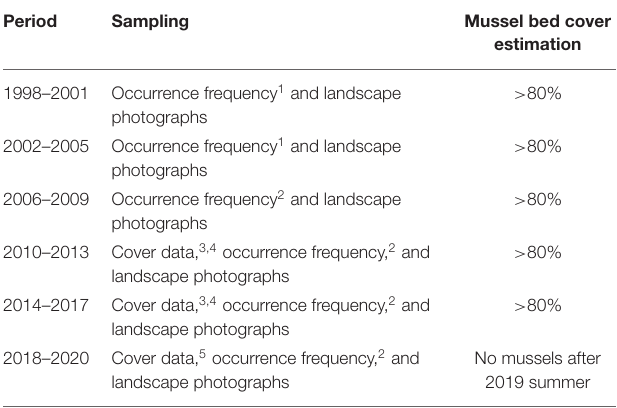
TABLE 2 | Natural dynamics of Punta Cuevas mussel bed between 1998 and 2020. Period